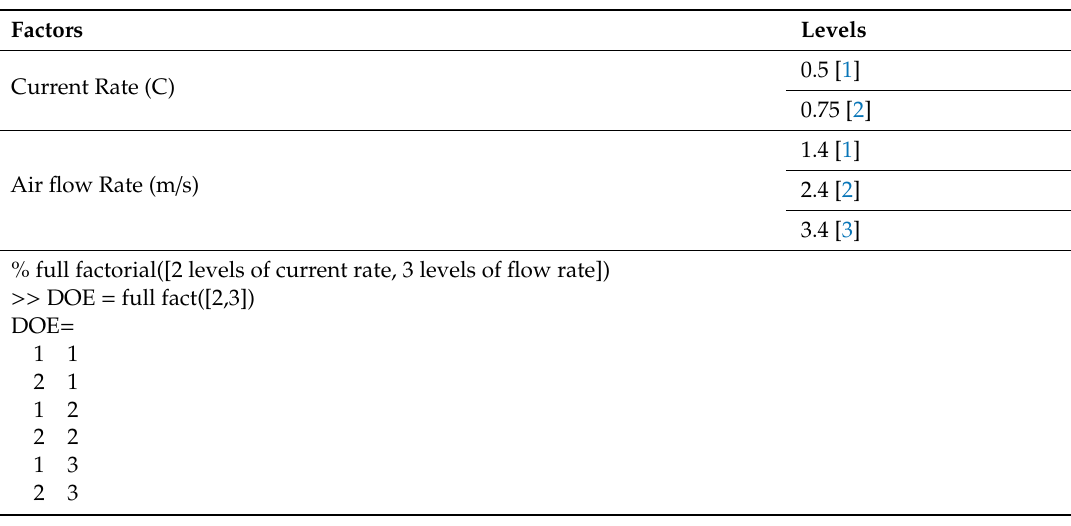
Table 3. Design of Experiment